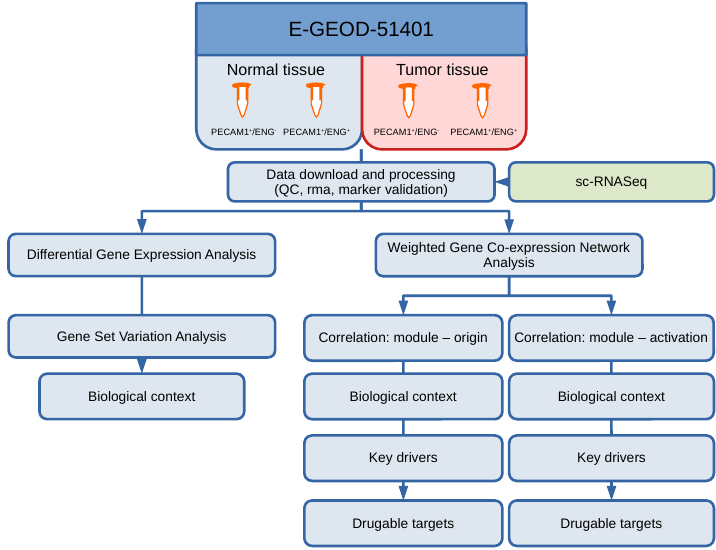
Figure 1. Workflow of the overall